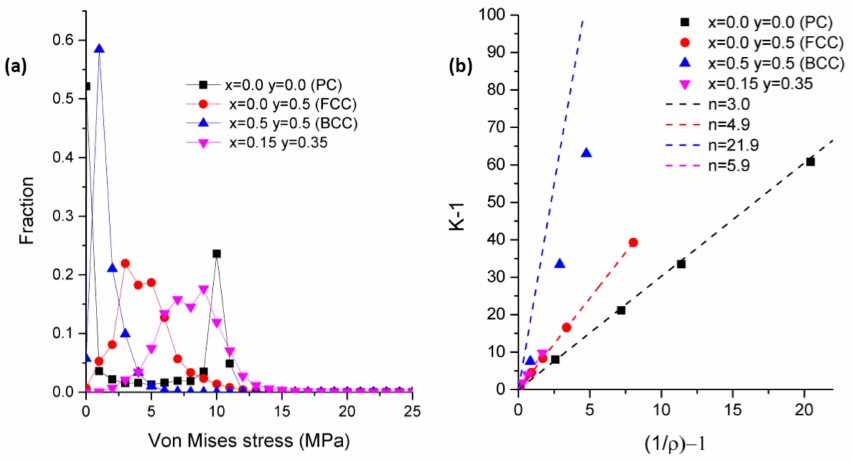
Figure 3. ( a ) Von Mises stress distribution in the set of elements for different architecture parameters; ( b ) stress concentration factor K as a function of density ρ